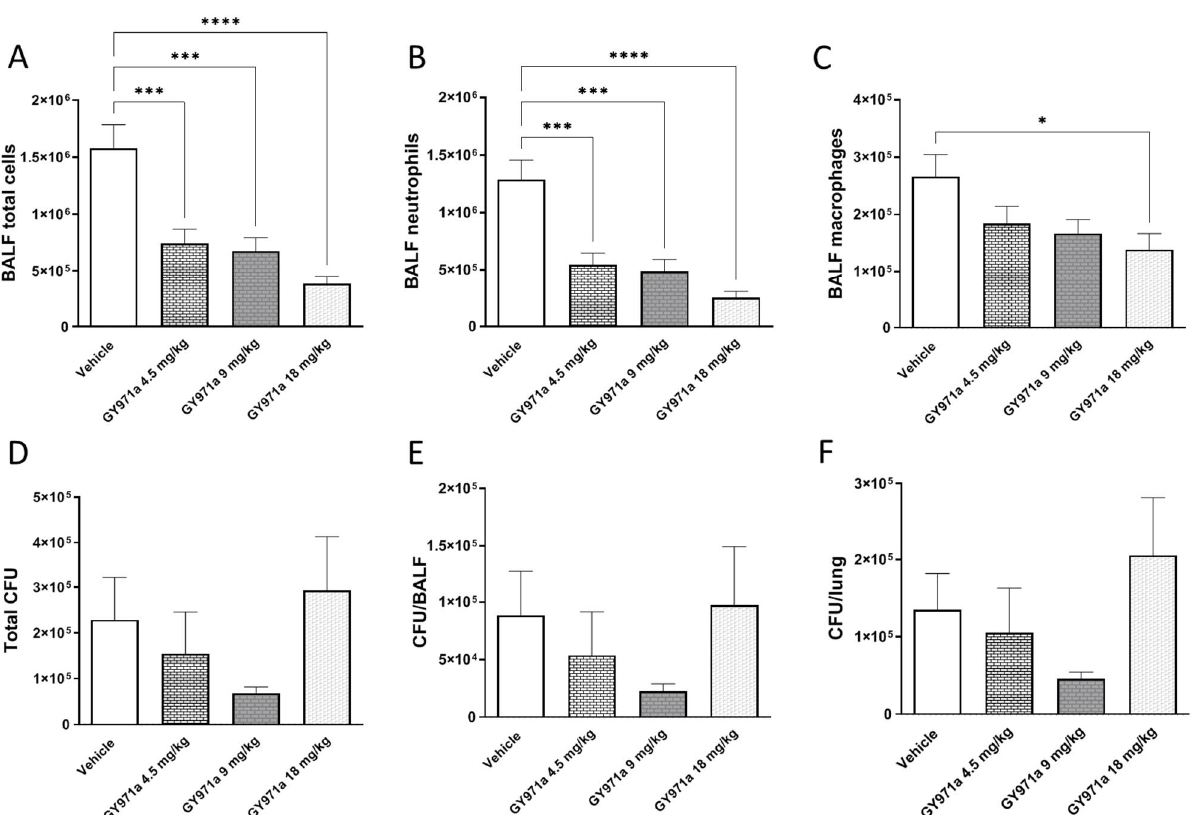
Figure 9. Efficacy of treatment with GY971a (pANDMA) in a murine model of acute lung infection. Mice were infected with 1 × 10 6 colony-forming units (CFUs) of planktonic PAO1. 5 min after infection, 4.5 mg/kg, 9 mg/kg and 18 mg/kg GY971a (pANDMA) or the vehicle was administered as an aerosol by Penn Century. After 6 h, mice bronchoalveolar lavage fluid (BALF) was collected and the lungs were excised, homogenized and plated on tryptic soy agar to determine the bacterial burden. Total cell ( A ), neutrophil ( B ) and macrophage ( C ) counts were performed in bronchoalveolar lavage fluid (BALF). Bacterial burden was evaluated in lung ( D ), BALF ( E ) and in total lung ( F ). Data are presented as the mean ± sem pooled from two independent experiments n = 10–12. Statistics were performed by one-way ANOVA with Dunnet’s multiple comparisons test, using Graph Pad Prism 9.0. * p < 0.05, *** p < 0.001, **** p < 0.0001 compared to